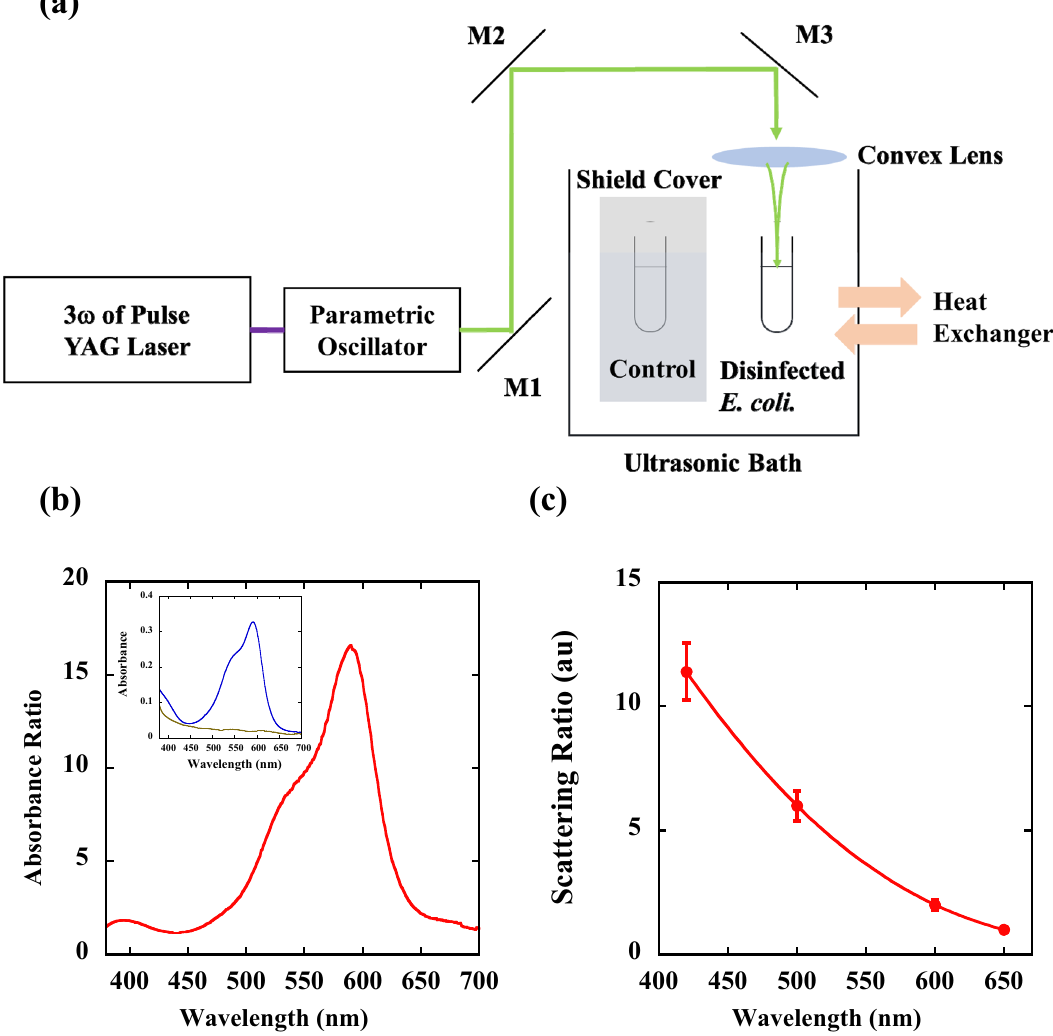
Figure 1. Experimental setup and optical properties. ( a ) Optical setup of the tunable pulse laser inactivation system. ( b ) Optical absorbance ratio (α cv /α 0 ) between stained (α cv ) and unstained (α 0 ) E. coli O1 solutions. The inset shows the optical absorption spectrum (absorbance) of unstained E. coli solution (brown line) and a crystal violet dye-stained E. coli solution (blue line). ( c ) Relative ratio of scattering intensity as a function of pulse laser wavelength for E. coli O1. Here, we normalize the scattering intensity of both stained (σ cv ) and unstained (σ 0 ) E. coli O1 to 1 at 650